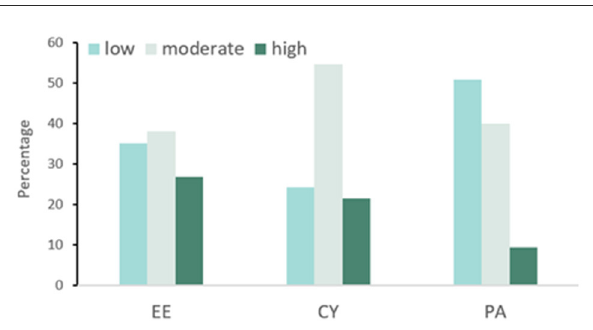
FIGURE2 Distribution of different severity levels in different dimensions in